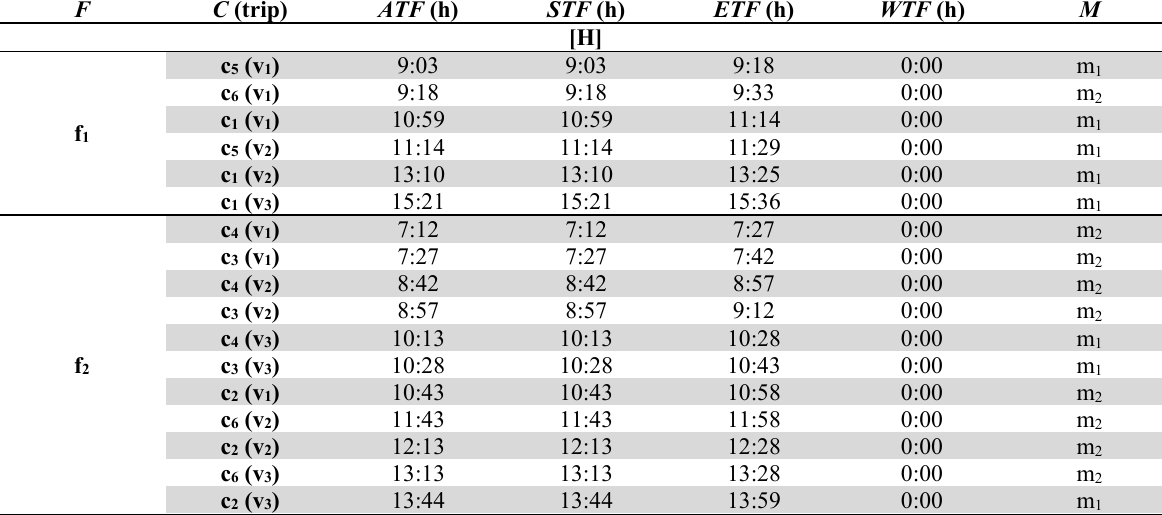
Table 6 Loading scheduling in the harvest areas (Continued)